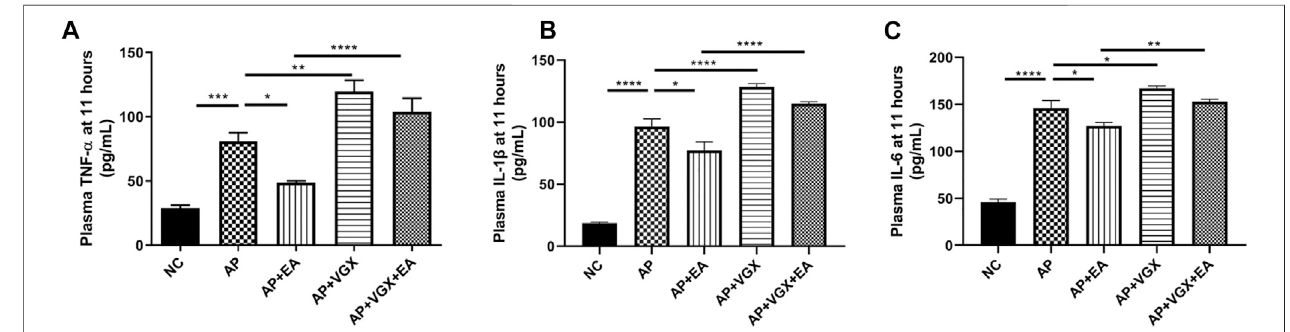
FIGURE3| EAdecreasessystemiccytokinesincaeruleinAPmice. (A) PlasmaTNF- α levelsat11 hafterthe fi rstcaeruleininjection. (B) PlasmaIL-1 β levelsat11 h. (C) Plasma IL-6 levels at 11 h, n (cid:1) 7 – 10. Bars show mean ± SEM. * p < 0.05, ** p < 0.01, *** p < 0.001, and **** p < 0.0001. NC, normal control; AP, acute pancreatitis; EA, electroacupuncture; VGX,